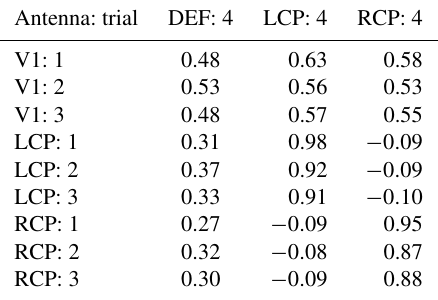
Table 10. Mean values of the real part of the complex correlation coefficients over frequency for different antenna pairs. The Roman numerals indicate from which measurement trial the measured sam- ple sequences of the specified antenna originate.